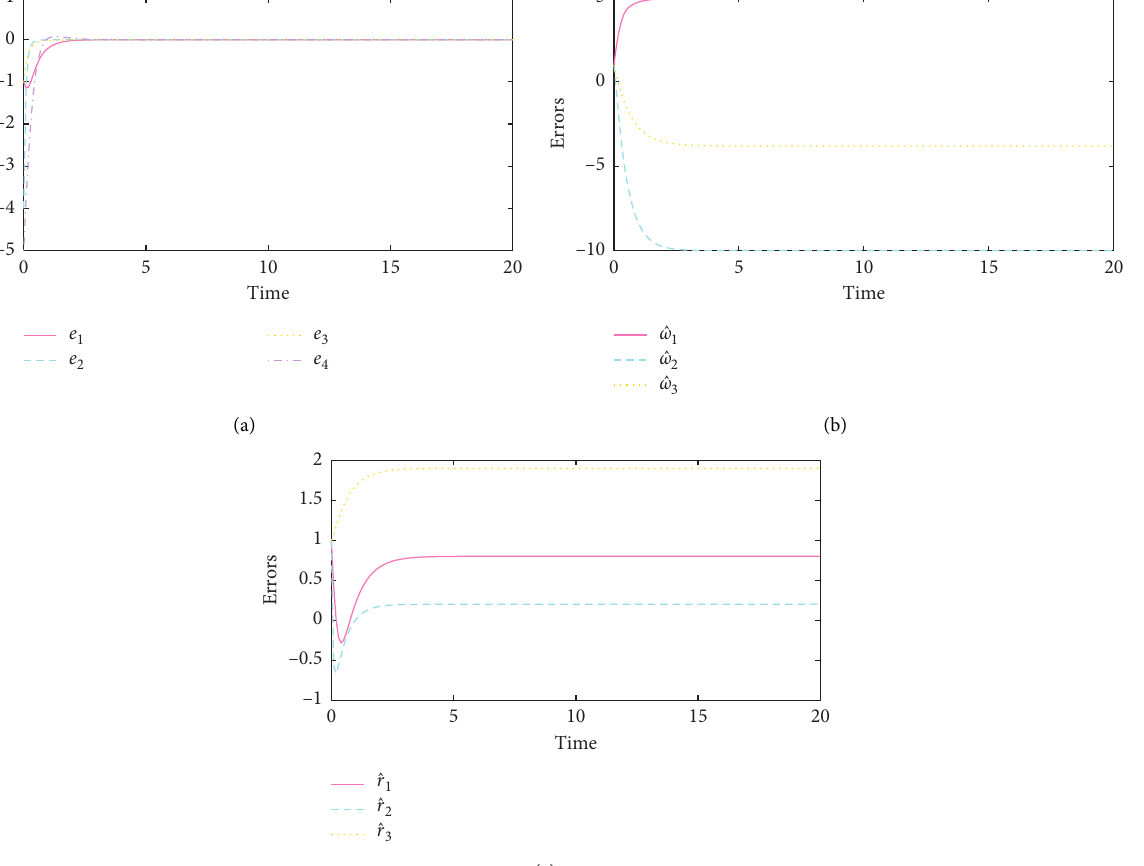
Figure 10: (a) Trajectories of the errors: (b) trajectories of the drive system unknown parameter estimates; (c) trajectories of the response system unknown parameter